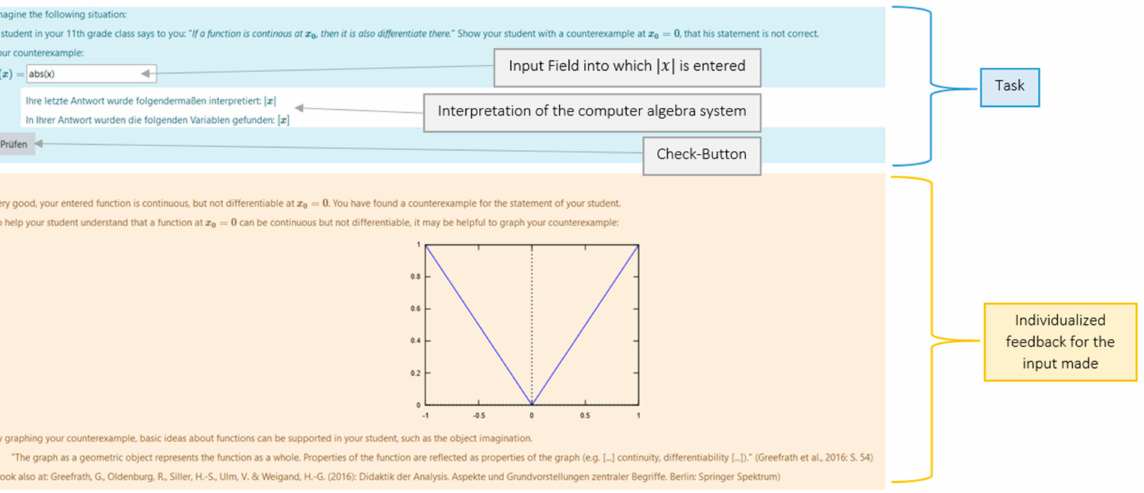
Figure 1. An exemplary STACK task with individualized feedback